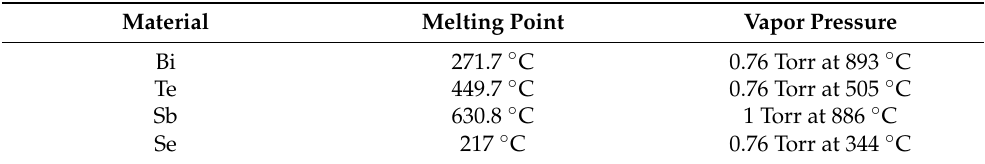
Table 1. Melting points and vapor pressures [42] of the constituent elements of the pellets and thermoelectric thin films.